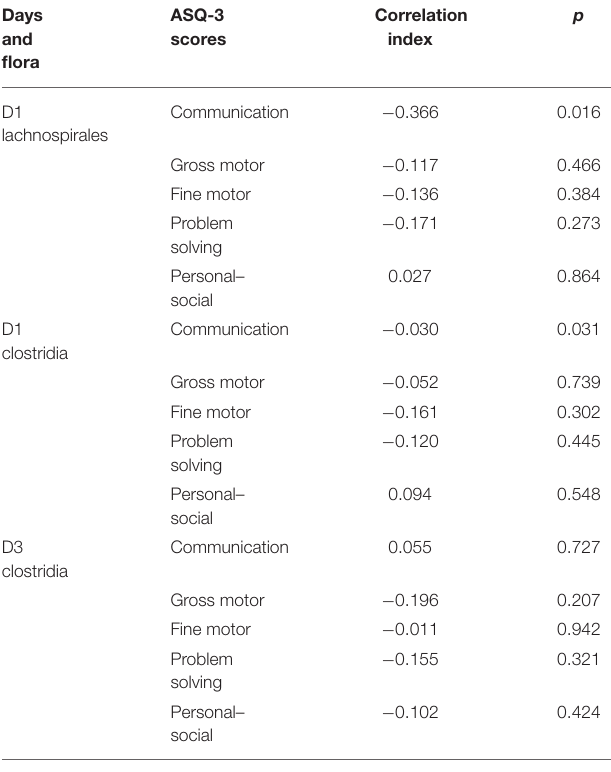
TABLE 3 | Correlation analysis between the dominant microflora of the study group and ASQ-3 scores at 6 months. Days